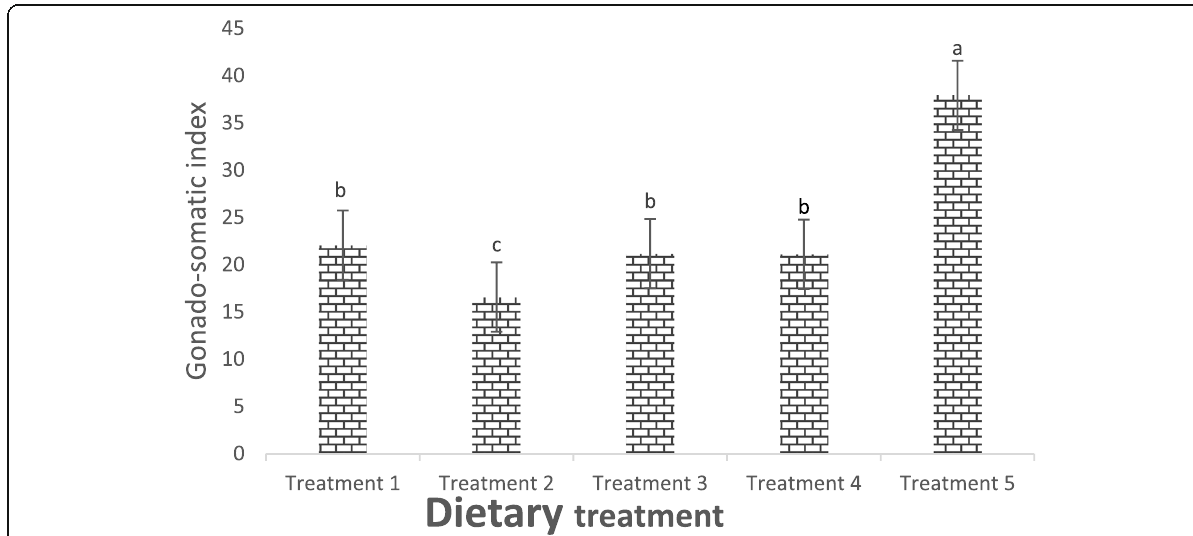
Fig. 1 Gonadosomatic index of laying snails fed with roughages and concentrate with different leaf proteins. abc: means with different superscripts are significantly ( p < 0.05)